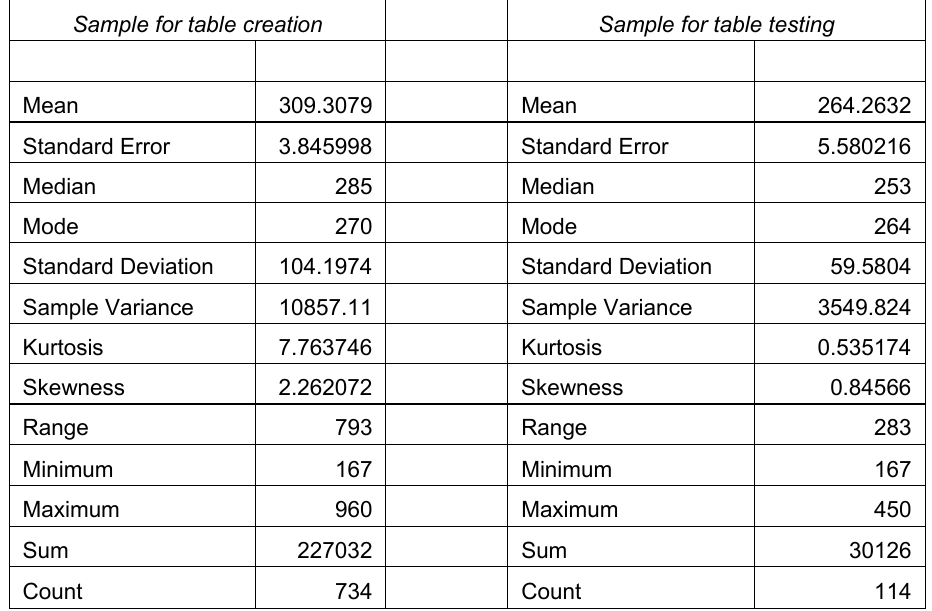
Table 4 – Scoring, descriptive statistics Таблица 4 – Дескриптивная статистика Табела 4 – Дескриптивн a